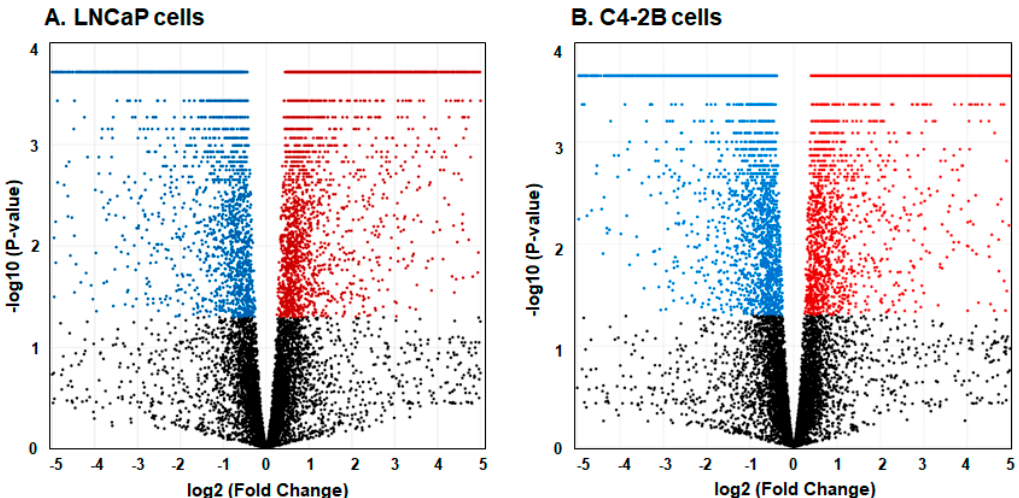
Figure 1. Volcano plot of ( A ) LNCaP enzalutamide resistant and ( B ) C4-2B enzalutamide resistant cells compared to their parental counterparts. The volcano plot displays the relationship between magnitude of gene expression change (log2 fold-change; X-axis) and statistical significance of this change [ − 1og10 of false discovery rate (FDR); Y-axis]. Each dot represents an individual gene. Red dots indicate the upregulated genes with Log2 fold-change > 2 p adjusted (FDR) < 0.005 and blue indicate downregulated genes with Log2 fold-change > 1.2 p adjusted (FDR) < 0.01, while the black dots represents non-significant genes.